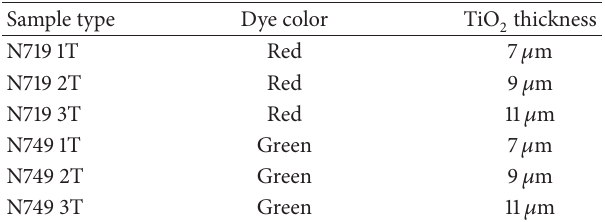
Table 1: Property of